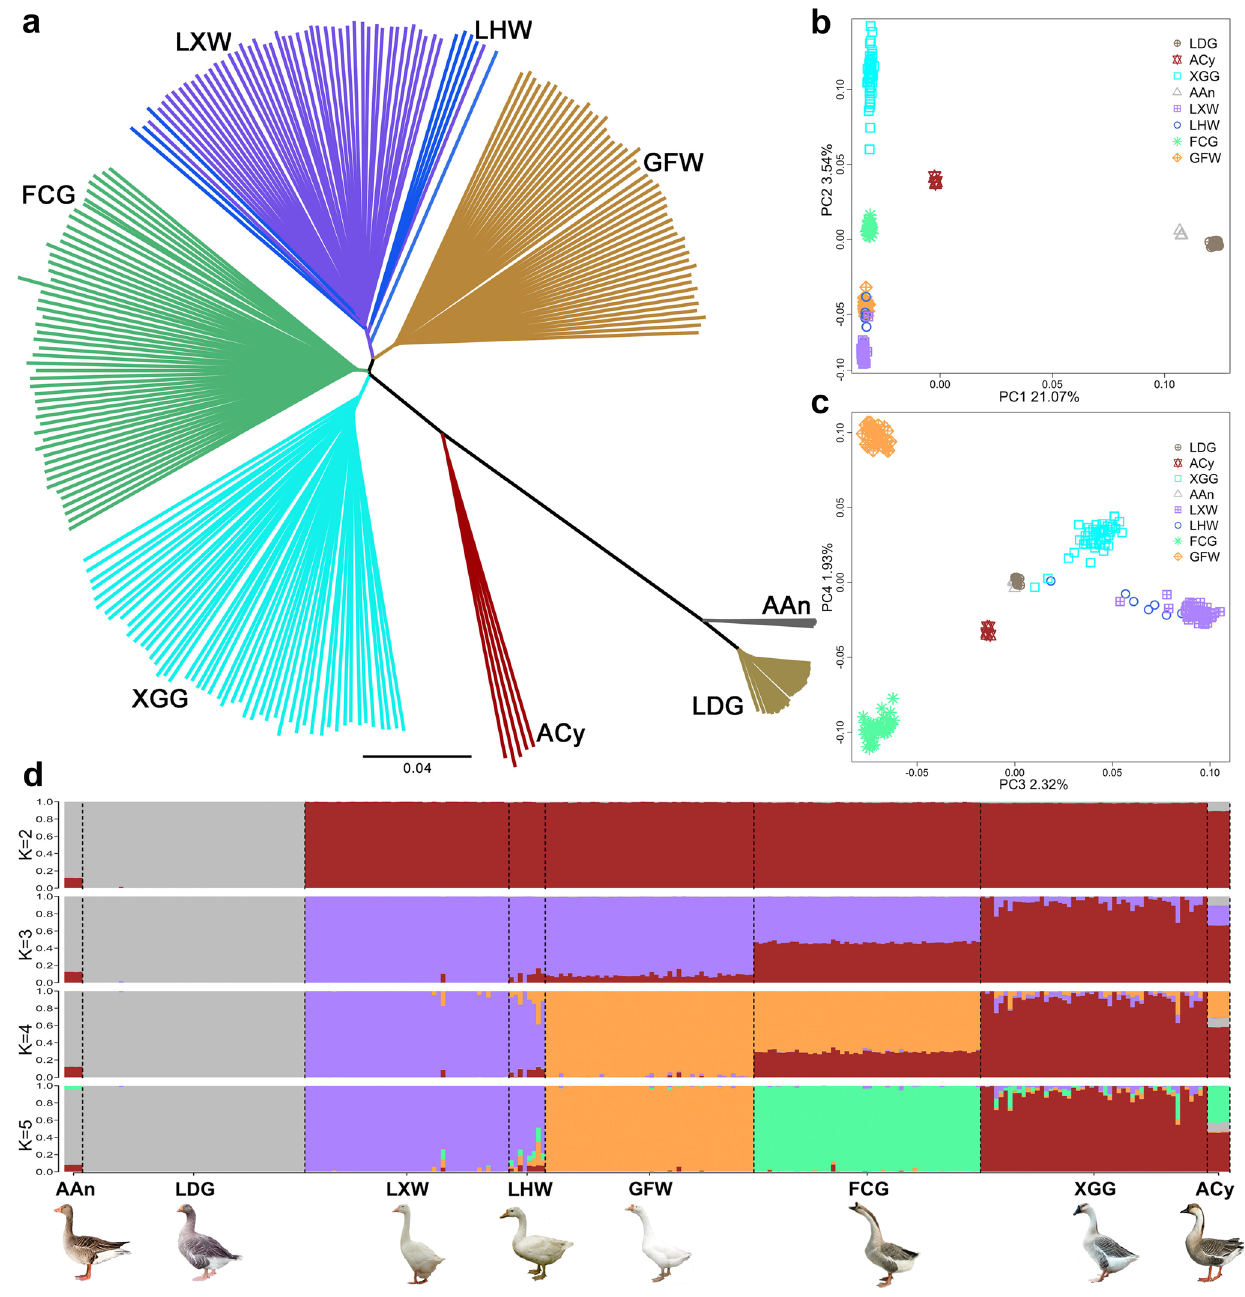
Fig. 3 Phylogenetic relationships and population structure of Chinese indigenous geese breeds. a The NJ tree was constructed by identical-by-state matrix of 257 goose individuals. b , c Principal component analysis of 257 goose individuals. PC1, PC2, PC3, and PC4 explained 21.07%, 3.54%, 2.32%, and 1.93% of the observed variance, respectively. d Ancestral composition of Chinese geese breeds. K = 2 – 5 represented the number of assumed ancestors ( K ), and each color represents an ancestral